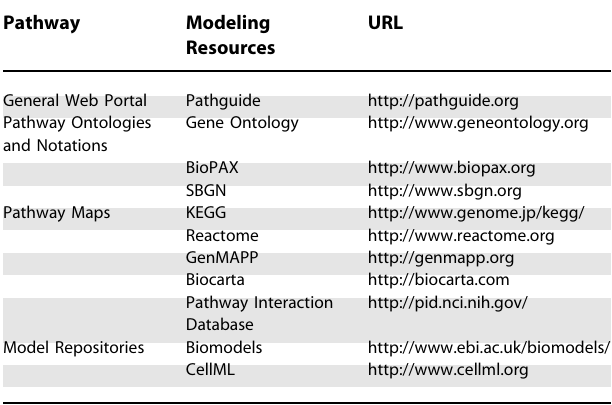
Table 1. A Few Major Pathway and Modeling Resources on